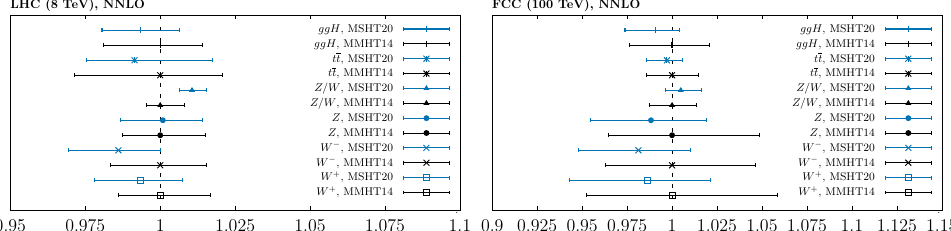
Figure 7: Predictions for benchmark processes for MMHT20 compared with those for MMHT14, for both 8 and 100 TeV